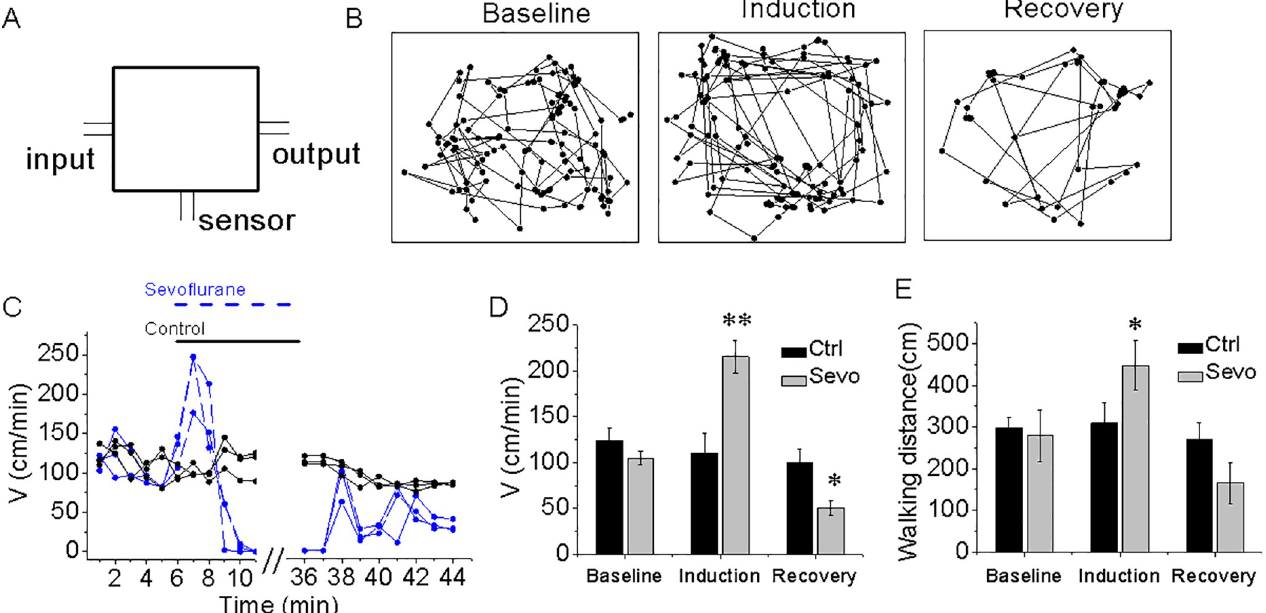
Fig 1. Sevoflurane increases locomotion in mice. (A) Diagram of the chamber used to treat the mice with sevoflurane (2%) in N 2 /O 2 and access locomotion. Control mice received only N 2 /O 2 . (B) Representative traces demonstrating the position of the mouse in the activity chamber before, during, and after administration of 2% sevoflurane anesthesia (C) the time-course of mean velocity of 3 mice per group during a single exposure to the sevoflurane or control condition. (D & E) Summary of mean velocity and walking distance for 2 minutes during each period of the baseline, anesthesia induction and anesthesia recovery of the sevoflurane-treated mice (green bar) and control condition mice (black bar). Data shown as mean and SEM, n = 4 and 6 for control and sevoflurane-treated group,